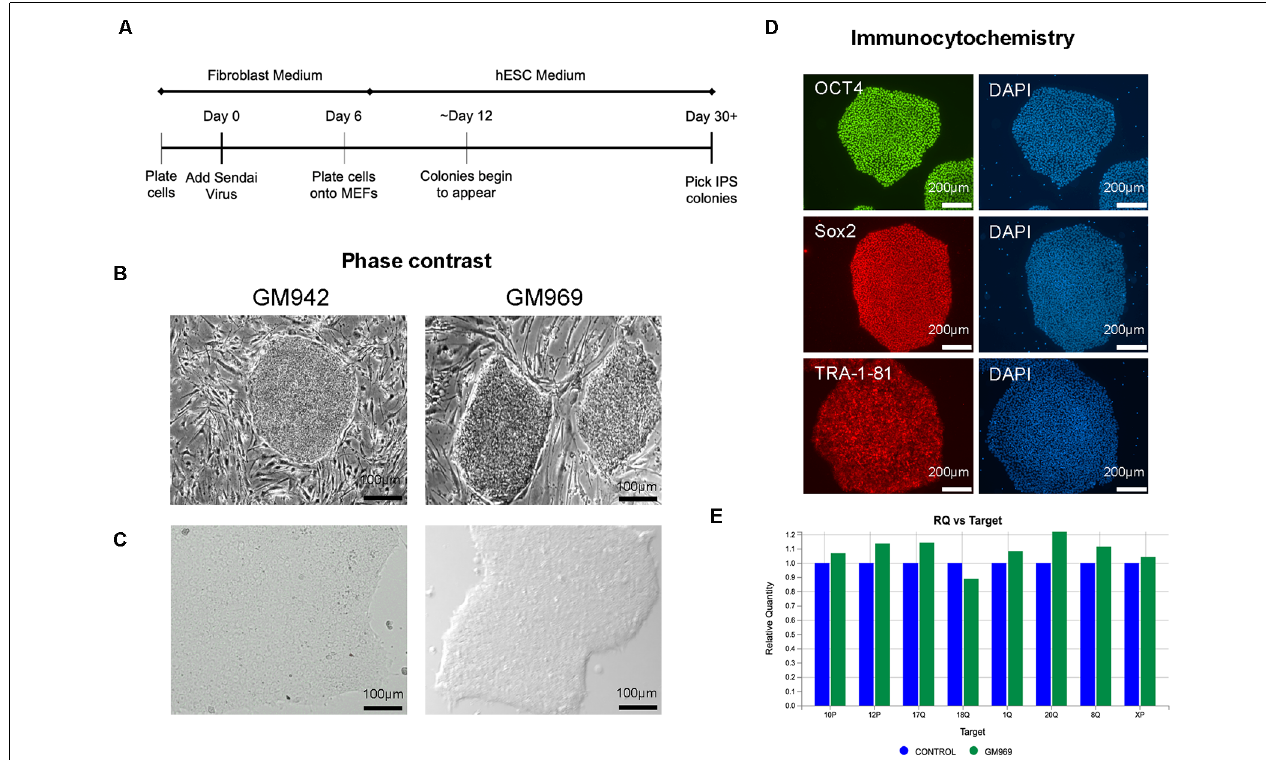
FIGURE 1 | Generation and characterization of human-induced pluripotent stem cells (iPSCs). (A) Timeline of Sendai Virus reprogramming from human fibroblasts. (B,C) Phase-contrast imaging of iPSC colonies in feeder-dependent culture (B) and feeder-free culture (C) . (D) Confirmation of iPSC identity using pluripotency markers, OCT4, SOX2, and TRA-1–81, using DAPI to stain nuclei. (E) Karyotypic analysis of iPSCs confirming no genomic abnormalities.